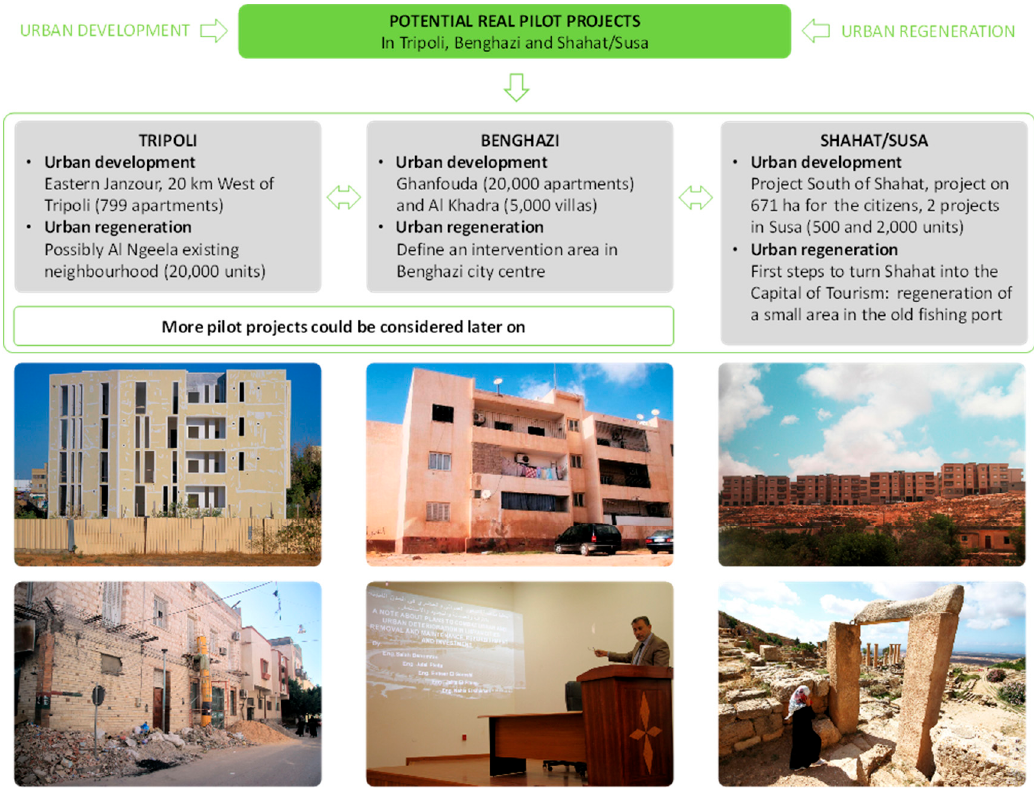
Figure 6. Potential Libyan EcoCity pilot projects in Tripoli, Benghazi and Shahat / Susa. (Ministry of Housing and Utilities of Libya, VTT Technical Research Centre of Finland Ltd. Photos: Pekka Huovila, 2013).